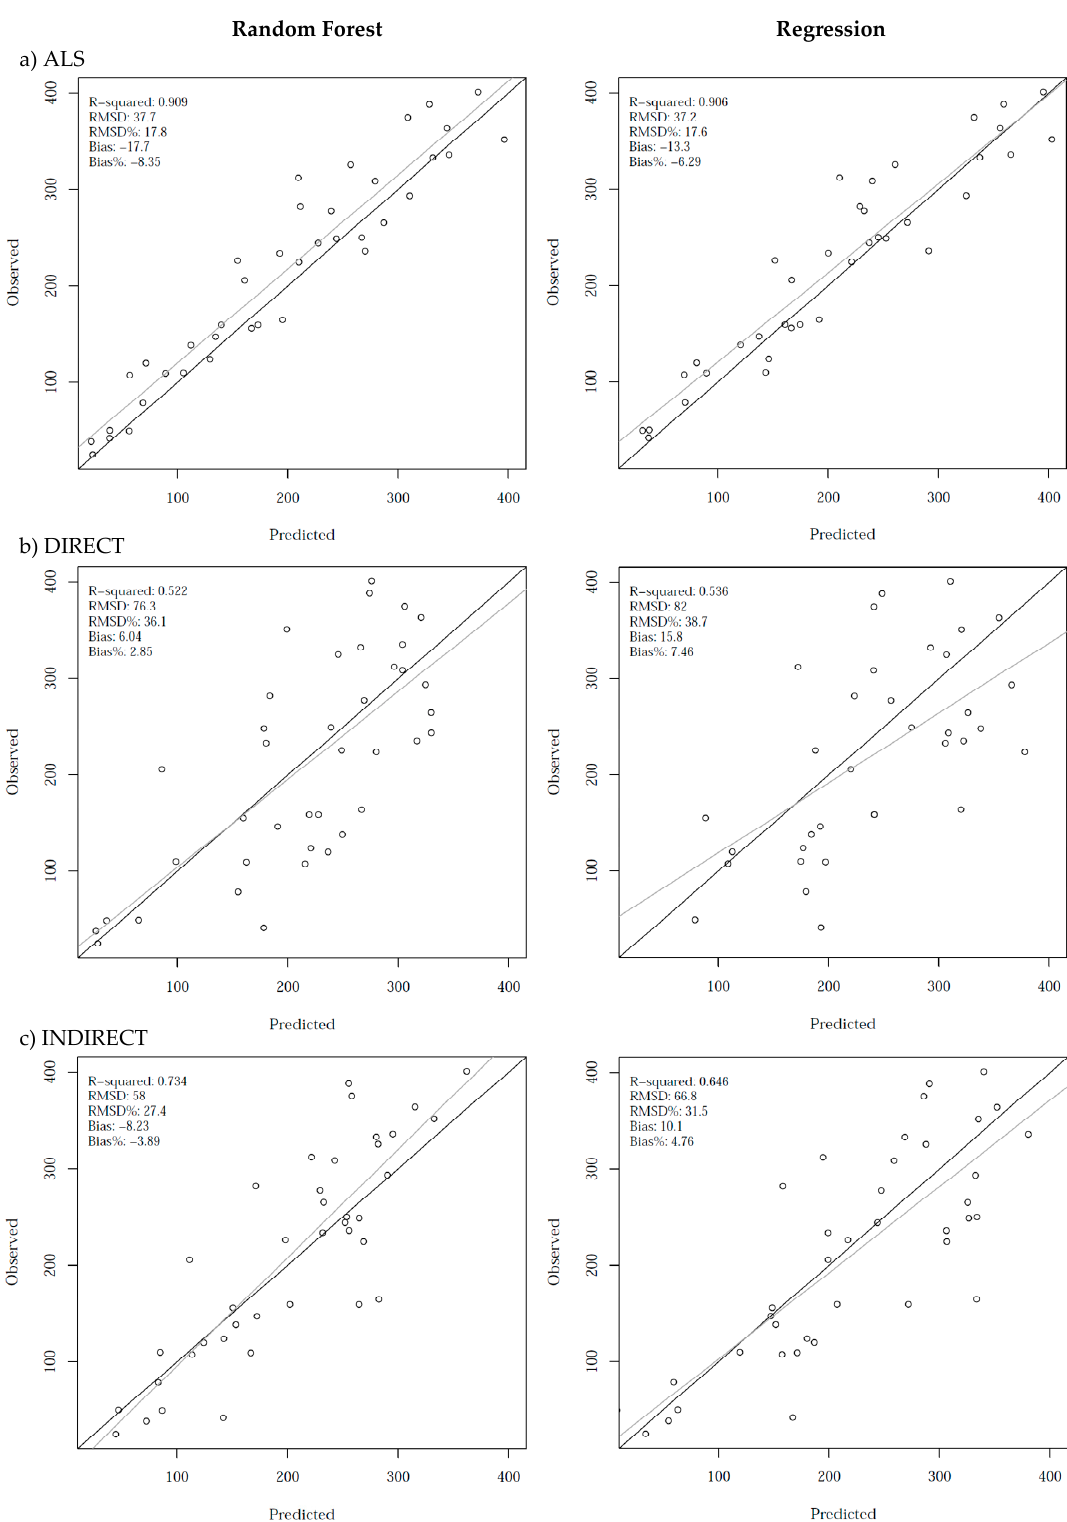
Figure 2. Observed versus predicted scatter plots of total volume (m 3 ha − 1 ) modeled with ( a ) ALS metrics, ( b ) direct approach, and ( c ) indirect approach. Graphs represent independent validation results of a single seed shown for illustrative purposes. Black lines are 1:1 reference lines; gray lines are regression lines.